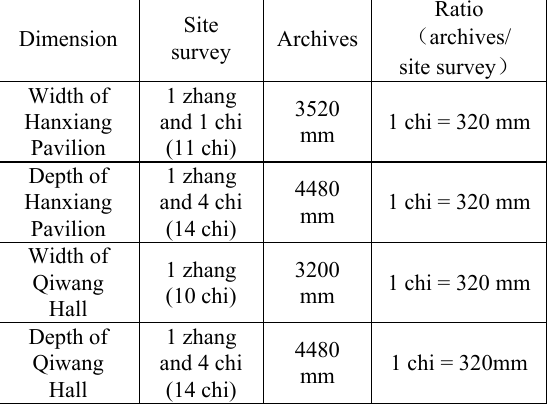
Table 1. Dimensional conversion